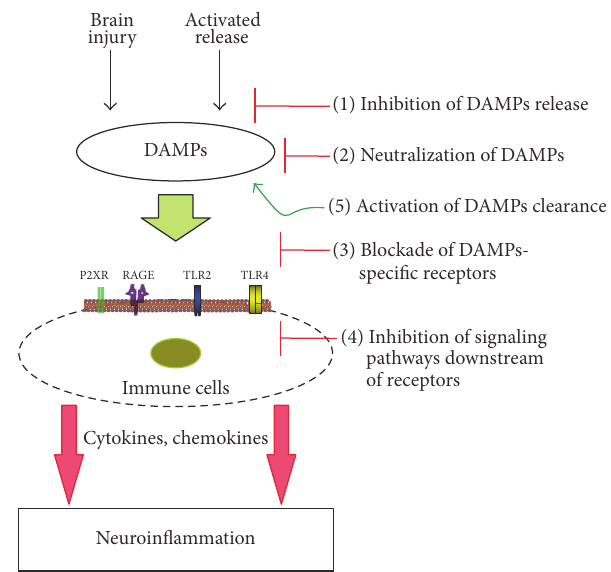
Figure 5: Drug treatment strategies for DAMPs-induced neuroin- flammation.Preclinicalstudieshaveidentifiedanumberofmultipo- tential drug targets that attenuates neuroinflammation triggered by DAMPs released after brain injury or excessive